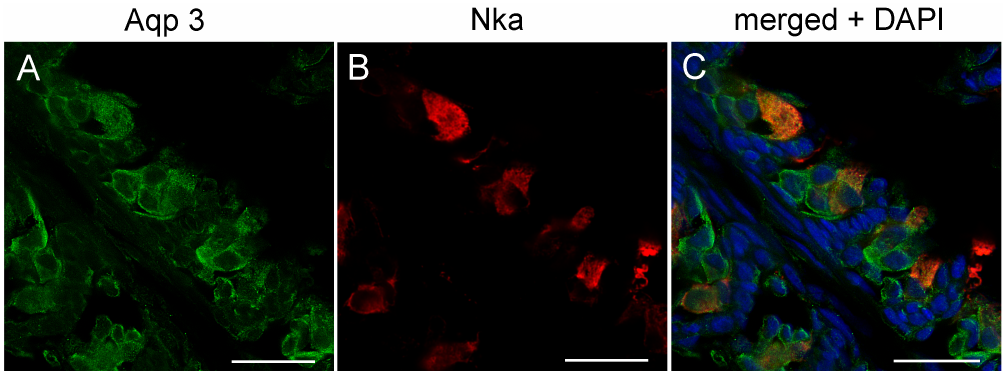
Figure 8. Confocal image of sagittal sections of FW medaka gills showing immunoreactivity against medaka ( A ) AQP3 (green), ( B ) Na + ,K + -ATPase (red), and ( C )merged channels overlaid with nuclear staining (blue 4’,6-diamidino-2-phenylindole (DAPI)). Scale bar = 20 µ